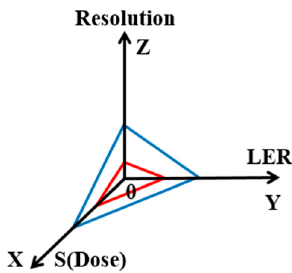
Figure 15. Resolution, dose sensitivity, and their relationship to low line edge roughness (LER).